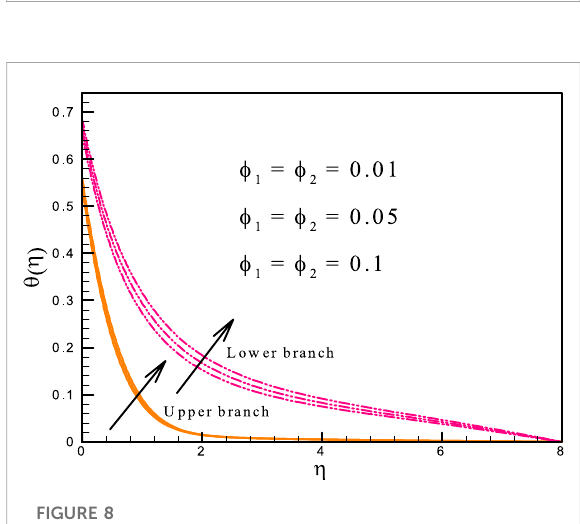
FIGURE 8 Interpretation of θ ( η ) for distant values of ϕ 1 and ϕ 2 .